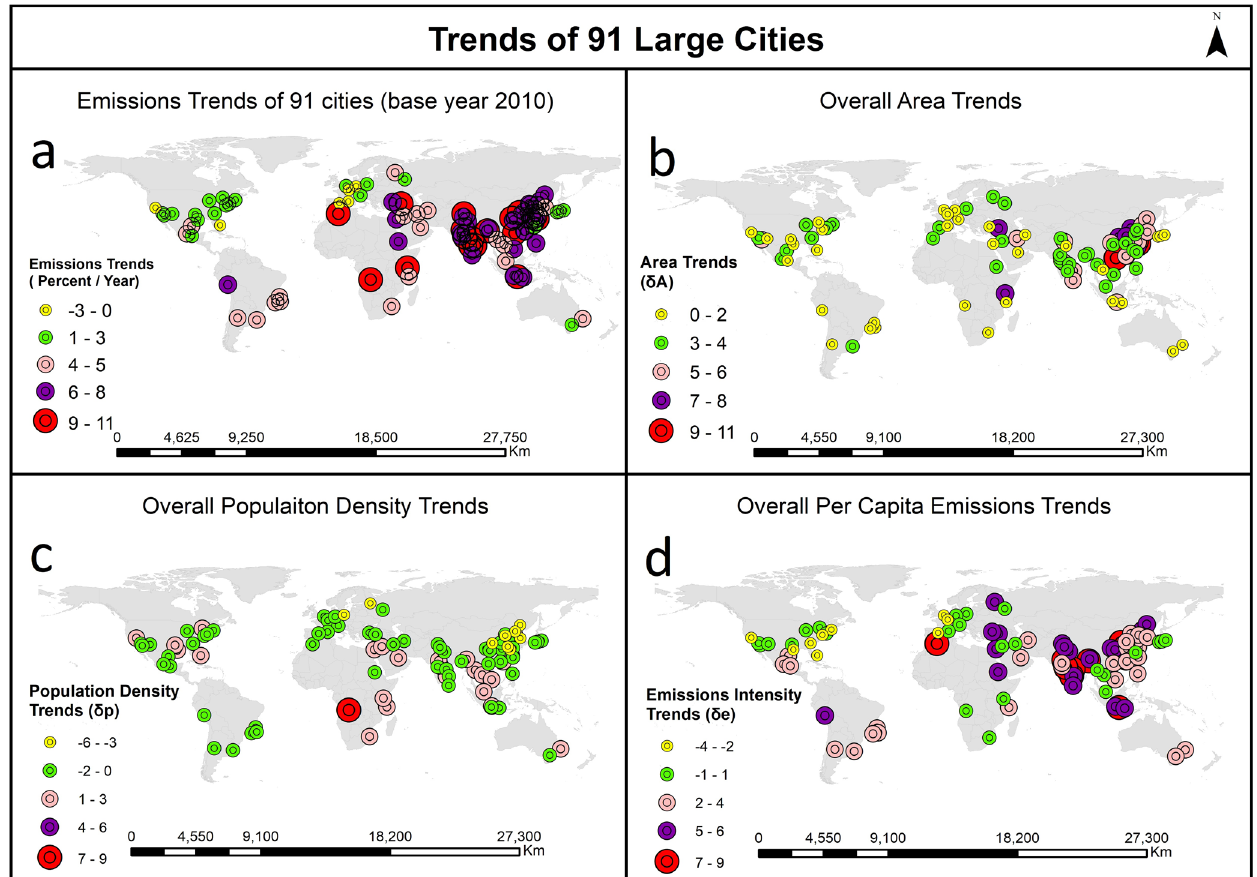
Fig. 1 Trends of 91 large cities. a Overall emission trends for 91 large cities b overall area trends, c overall population density trends, and d overall per capita emissions trends. Circles show the location of the chosen Table 1. List of excluded cities. Sr. No.